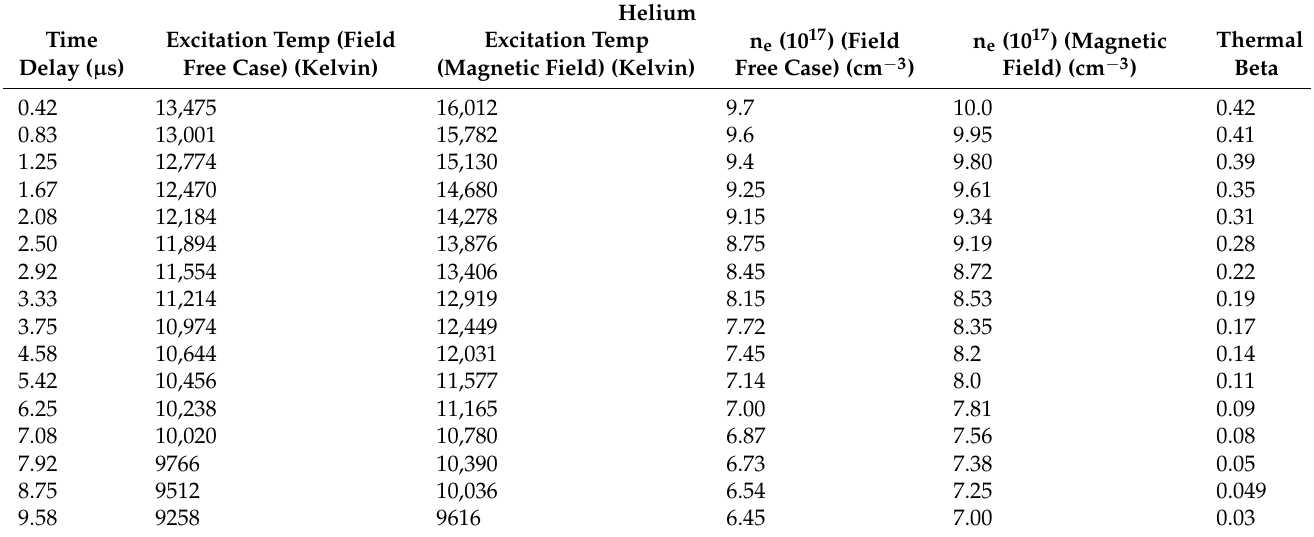
Table 7. Evaluated values of excitation temperature, electron number density, and thermal beta for LPP of Mg under He environment at different time delays with and without TMF.